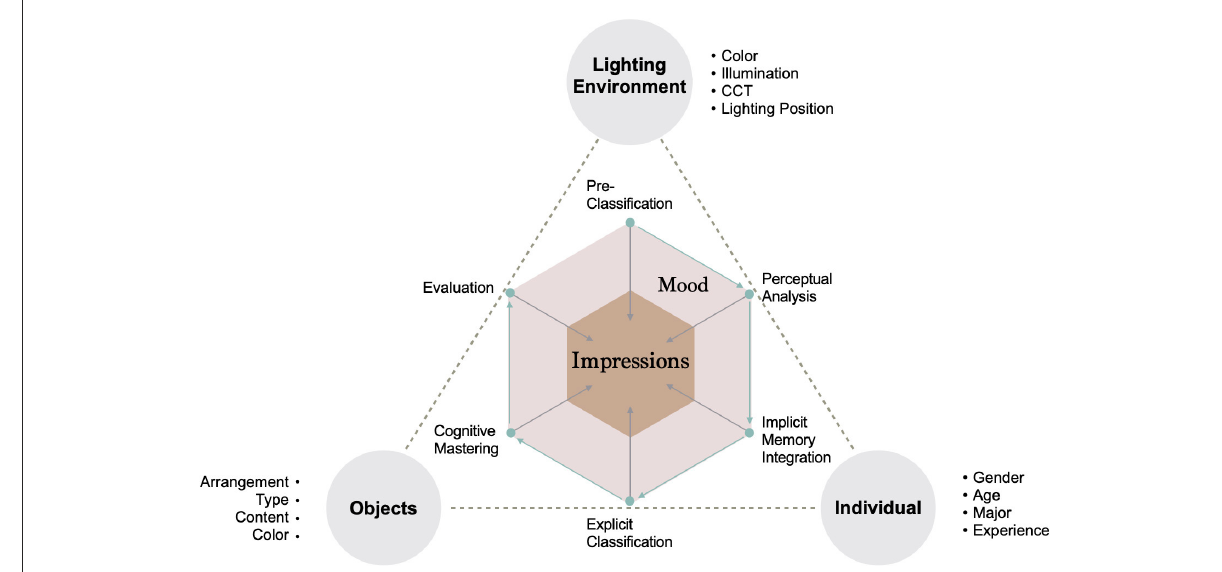
FIGURE1 Conceptual model of the experiment (Leder et al., 2004; Leder and Nadal, 2014; Pelowski et al., 2017; Mastandrea et al., 2021).